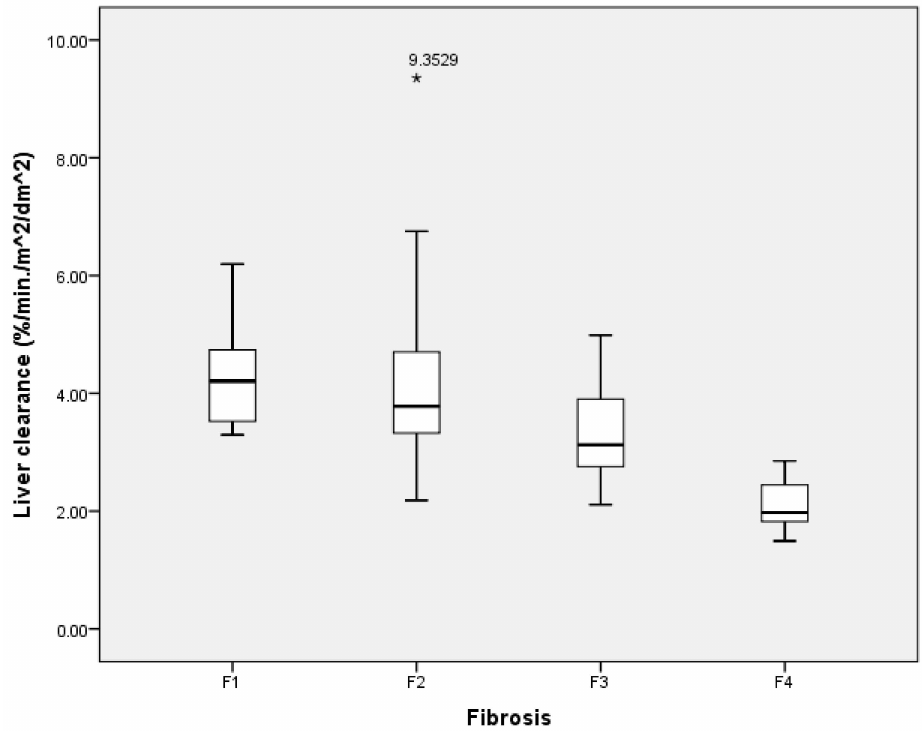
Figure 2. Box plot of the liver clearance (LCL) median, measured using dynamic liver scintigra- phy with 99mTc-mebrofenin in different liver fibrosis categories according to the METAVIR score. Median values: F1—4.21%/min/m 2 /dm 2 ; F2—3.78%/min/m 2 /dm 2 ; F3—3.13%/min/m 2 /dm 2 ; F4—1.98%/min/m 2 /dm 2